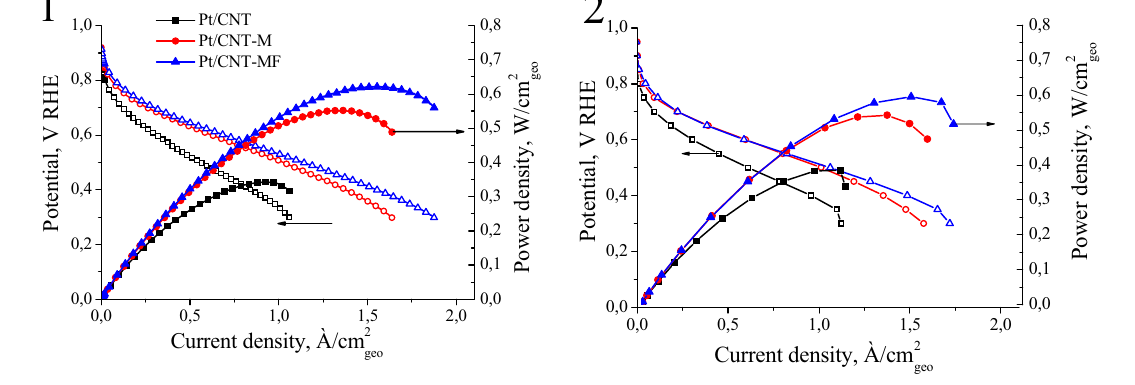
Fig. 6 Polarization (open symbols, left axes) and power (filled sym- bols, right axes) characteristics of the MEAs based on Pt/C catalysts. 1 Mode 1 (galvanostatic); 2 Mode 2 (potentiostatic). Experimental